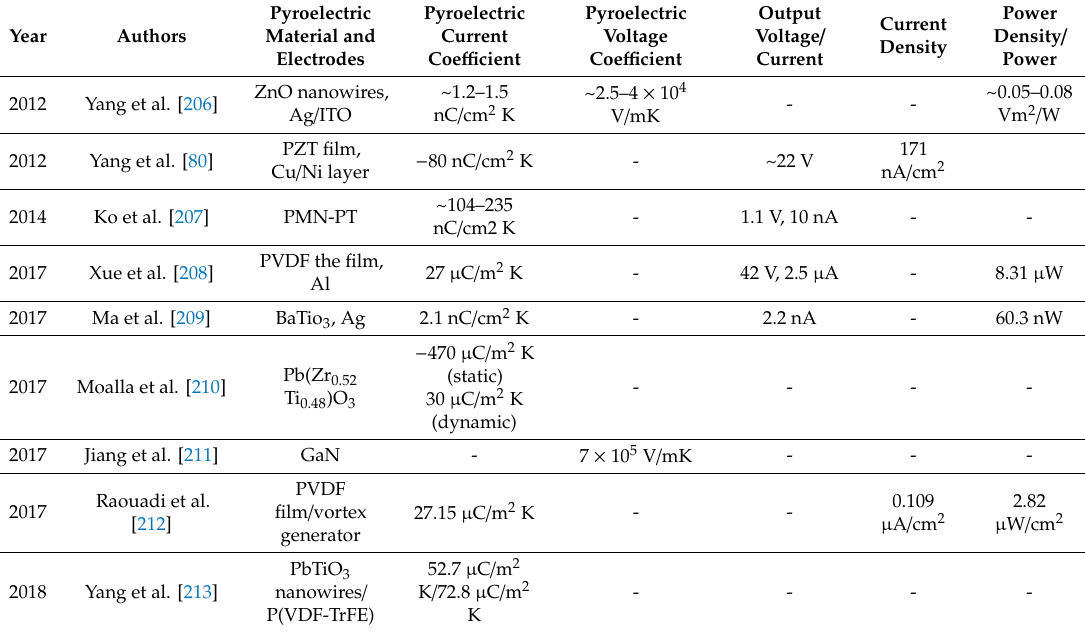
Table 6. Significant improvements in the development of pyroelectric nanogenerator